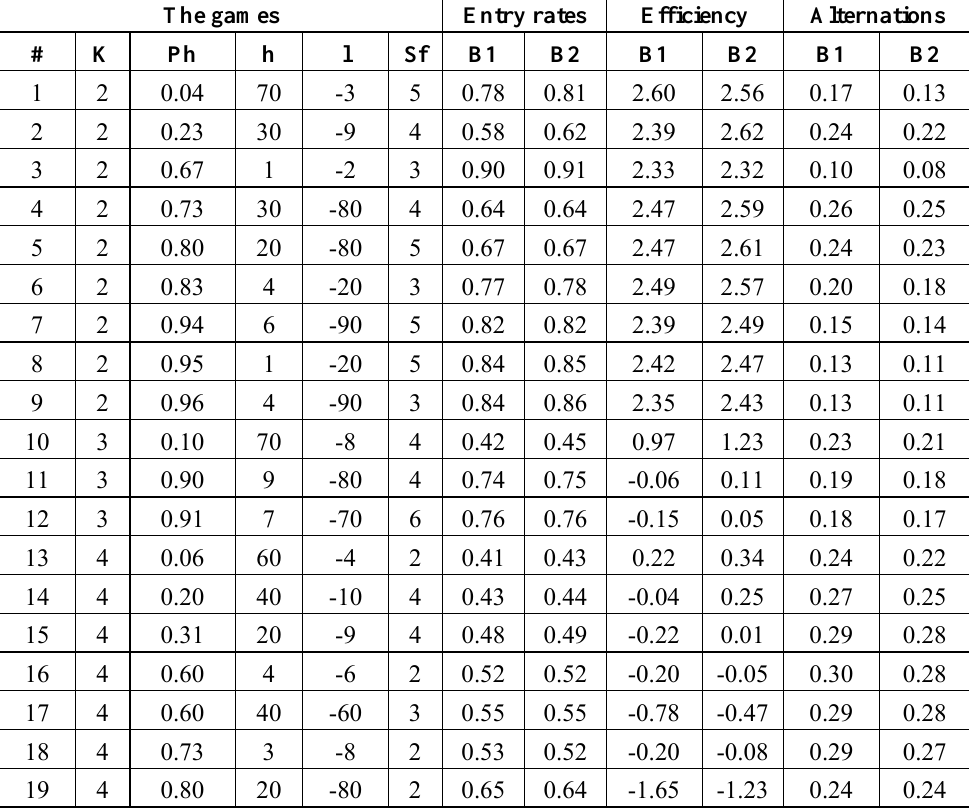
Table 5. The predictions of the best baseline models (I-SAW): The lowest row presents the correlation with the experimental results by